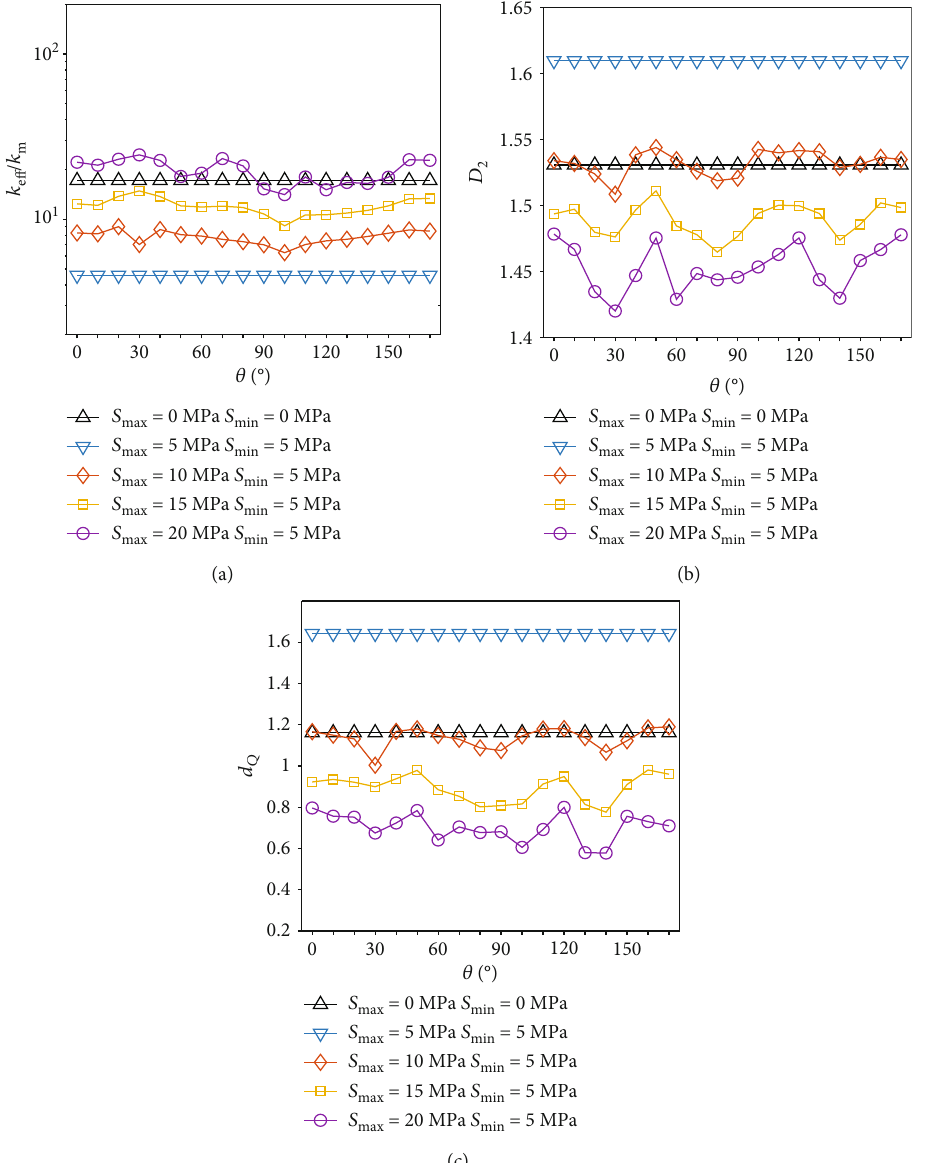
Figure 10: Quantitative indices for evaluating fl ow magnitude and distribution in fracture networks under di ff erent stress condition after removing the new cracks: (a) e ff ective permeability, (b) correlation dimension of fl ow rate, and (c) fl ow channeling density